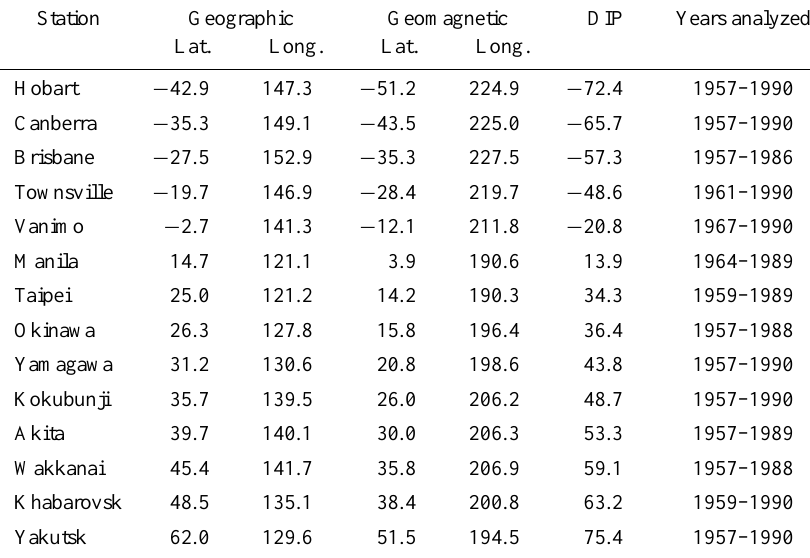
Table 1. The ionosonde stations and years analyzed. Station Geographic Geomagnetic DIP Years analyzed Lat. Long. Lat. Long. Hobart − 42 .